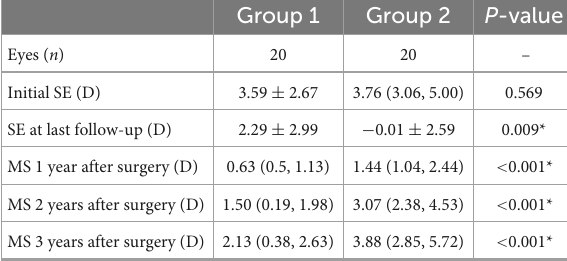
TABLE 2 Refractive outcomes of the two